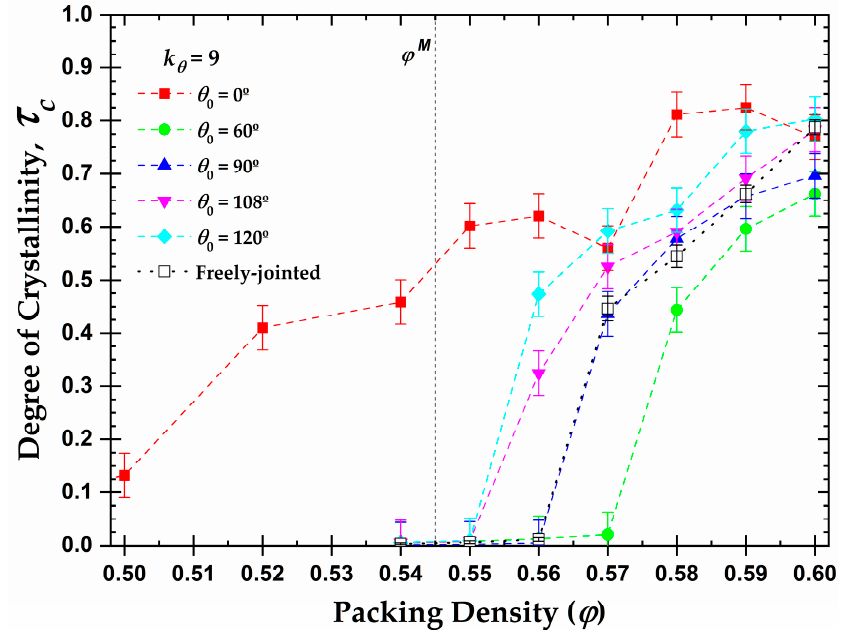
Figure 10. Degree of crystallinity, τ c , as a function of packing density, ϕ , and equilibrium bending angle, θ 0 , for 100-chains N av = 12 systems of semi-flexible chains with bending constant k θ = 9 (filled symbols) and freely-jointed chains (open square). Dashed lines connecting points are used as visual support. Vertical dashed line corresponds to the melting transition ( ϕ M monomers ≈ 0.545 ) for monomeric hard spheres